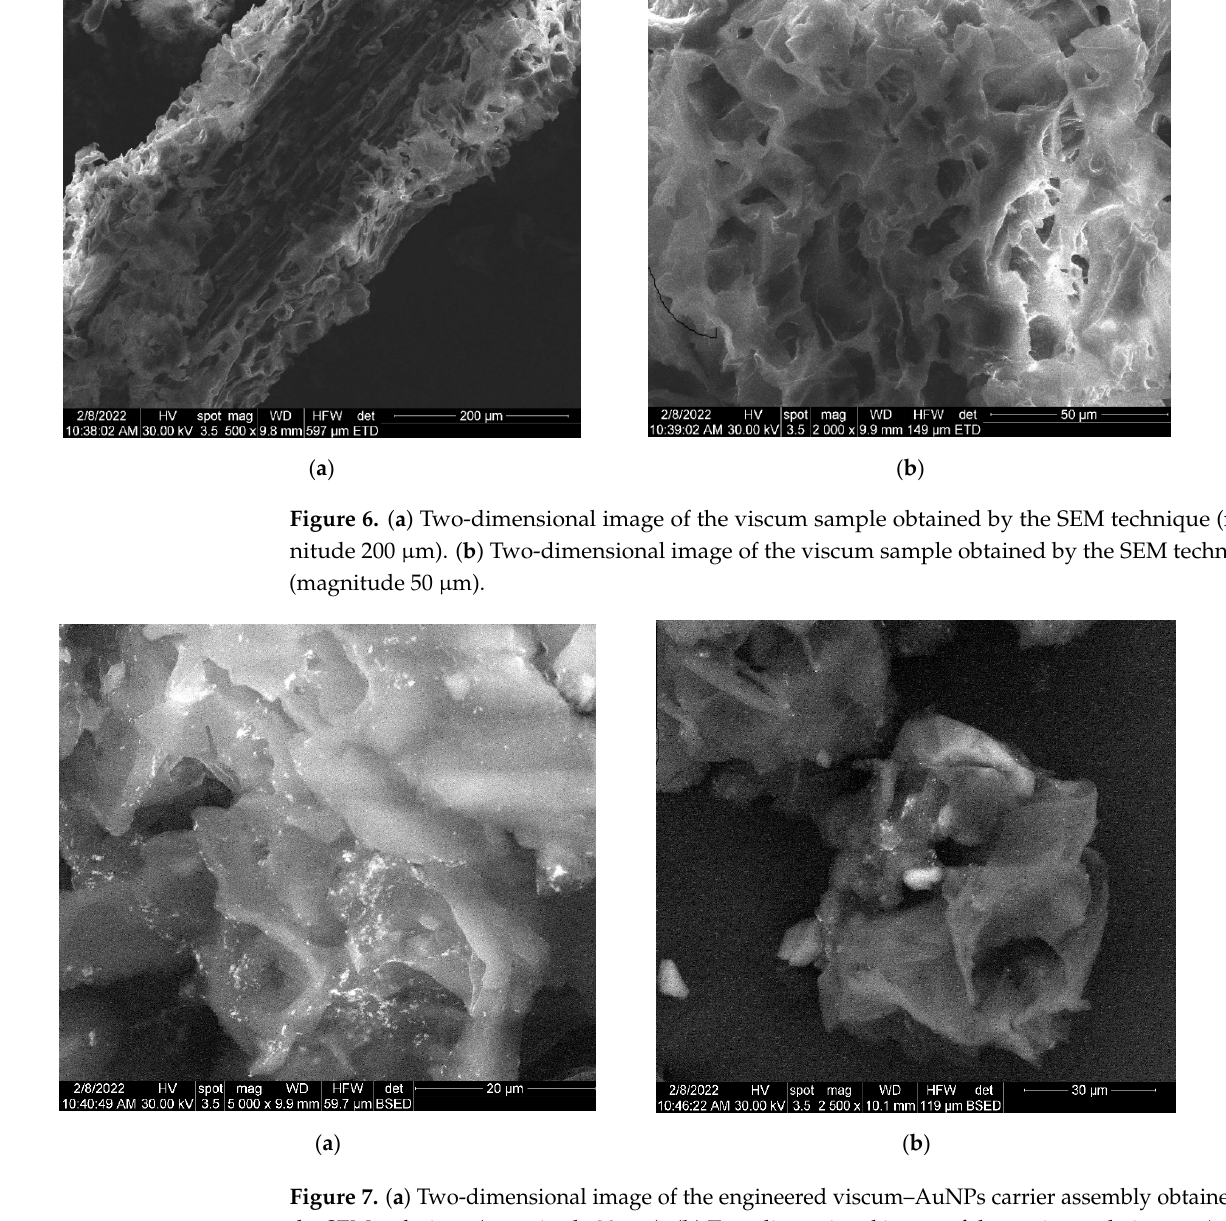
Figure 7. ( a ) Two-dimensional image of the engineered viscum–AuNPs carrier assembly obtained by the SEM technique (magnitude 20 µm). ( b ) Two-dimensional image of the engineered viscum–AuNPs carrier assembly obtained by the SEM technique (magnitude 30 µm).